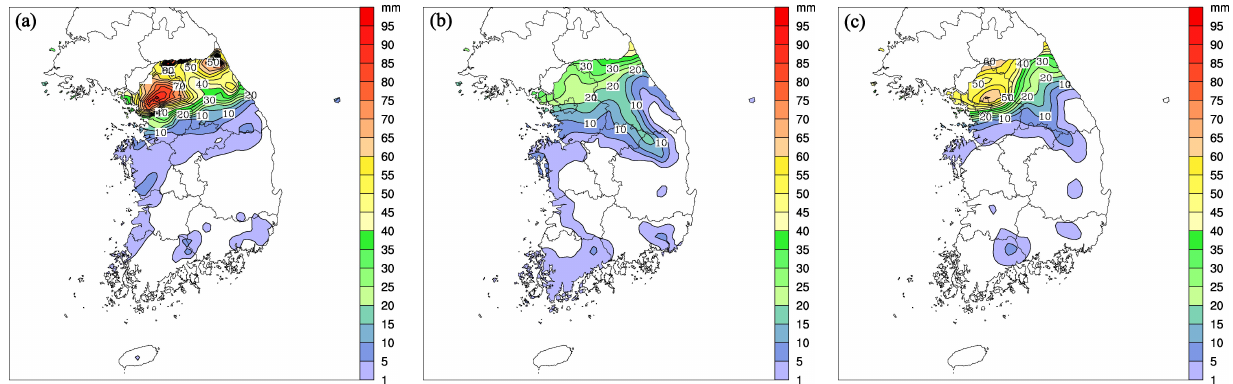
Fig. 2. A 6-h accumulated precipitation (in mm) of (a) observation from 592 rain gauge data, and experiments with (b) the default parameters and (c) the GA-estimated parameters, ending at 1800 UTC 26 June 2005. The model output is interpolated to the rain gauge locations for verification.